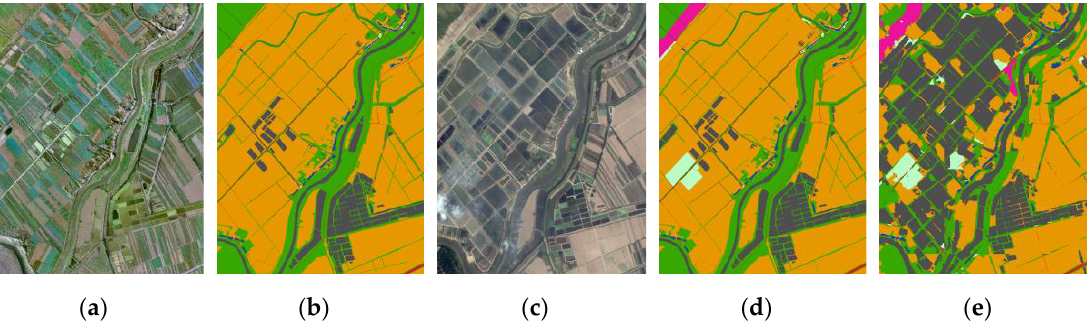
Figure 12. A case of human and algorithm interpretation inconsistency. Image in 2014 ( a ) and in 2017 ( c ) were both classified to cropland (yellow) by human as ground truth ( b ) and ( d ). However, a large part of area was classified into water by the algorithm ( e ) because of the irrigation season of paddy.